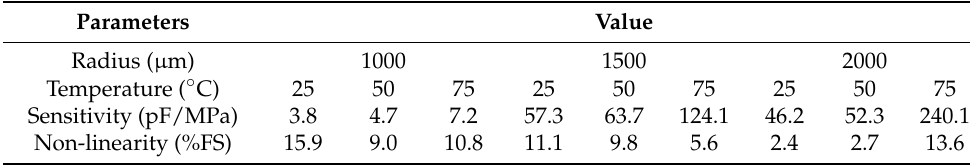
Table 2. Parameters of CPSs with different radii of diaphragms.